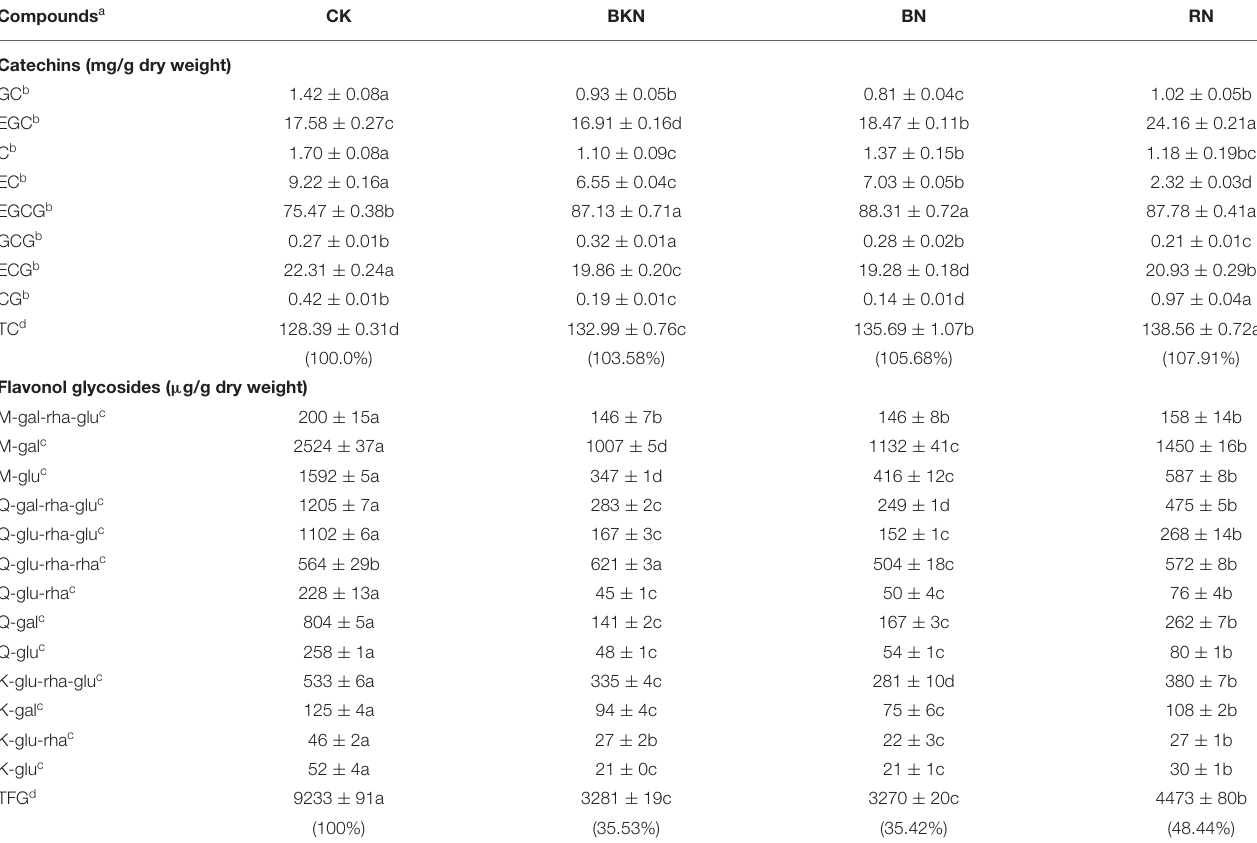
TABLE 2 | The contents of catechins and flavonol glycosides in the fresh tea leaves under different shading treatments. Compounds a CK BKN BN RN Catechins (mg/g dry